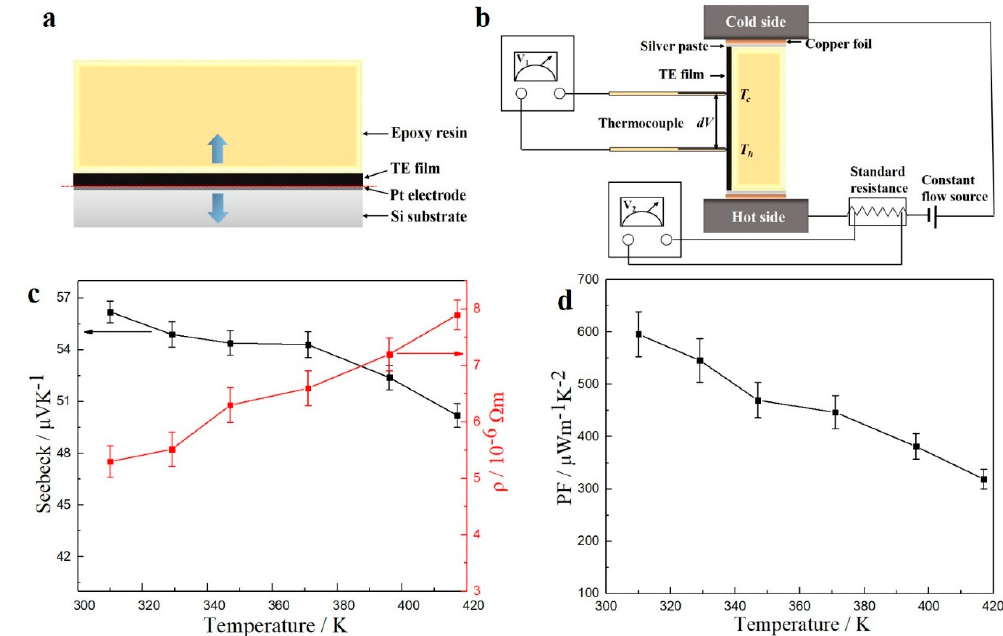
Figure 4. ( a , b ) The schematic diagram of testing method for electrical properties for Te thin films deposited at − 300 mV from the electrolyte of 8 mM SbO + and 12 mM HTeO 2+ . Electrical resistivity and Seebeck coefficient ( c ) and power factor ( d ) values of TE film as function of temperature from 310 K to 417 K in helium atmosphere.